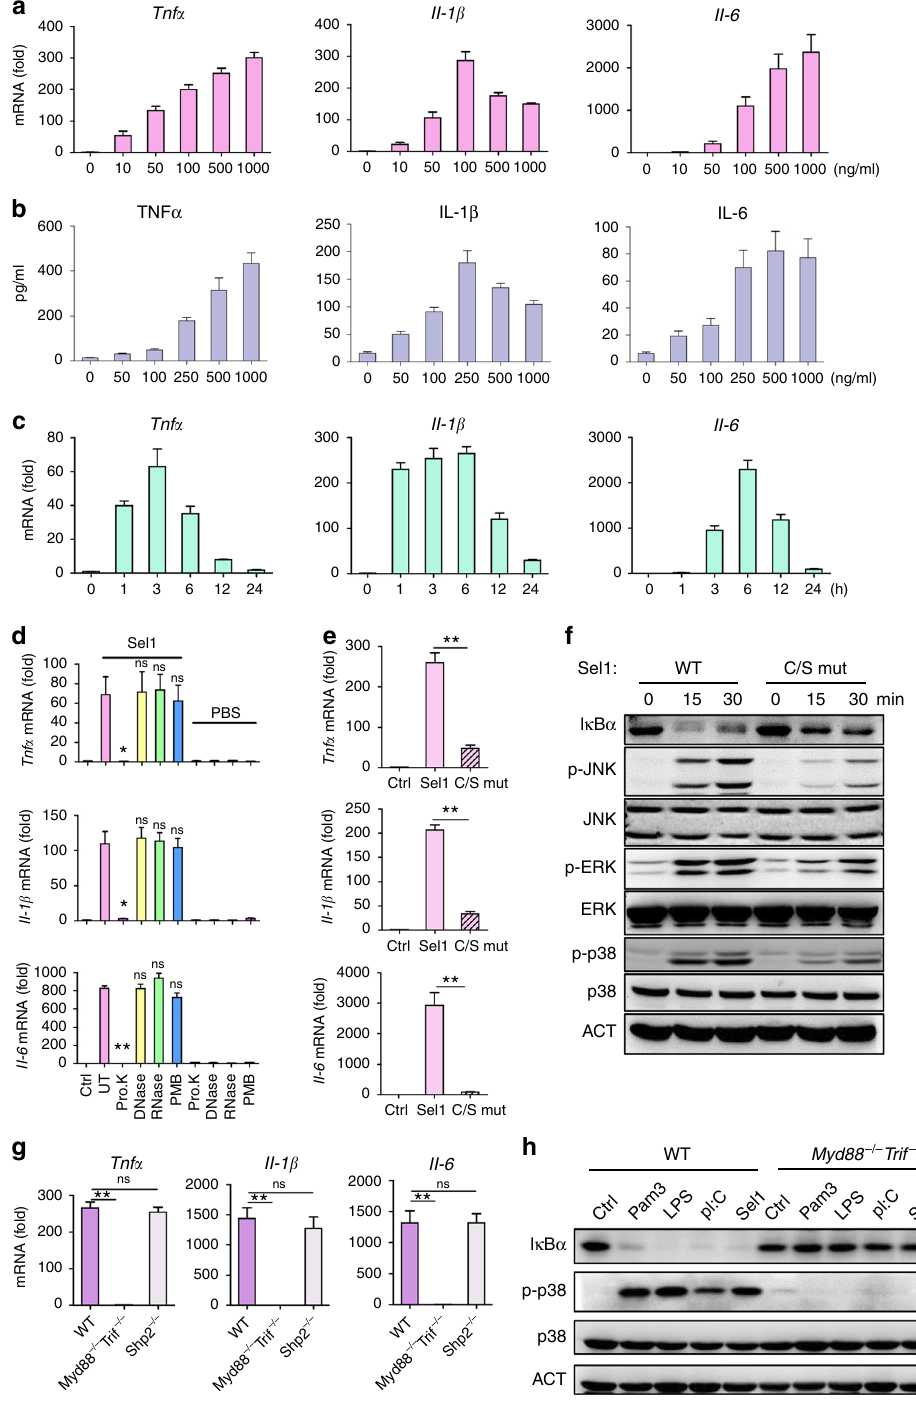
Fig. 3 Sel1 activates MyD88/Trif-dependent in fl ammatory responses. a , b Bone marrow-derived macrophages (BMDMs) were stimulated with different doses of Sel1 for 3 h ( a ) or 24 h ( b ), and the cytokine production was assessed by real-time quantitative PCR (qRT-PCR) ( a ) or by enzyme-linked immunosorbent assay (ELISA) ( b ), respectively. c BMDMs were stimulated with 300 ng/ml of Sel1 for various times and the cytokine production was assessed by qRT-PCR. d The Sel1 proteins were either untreated (UT) or treated with proteinase K, DNase, RNase or PMB, prior to stimulation. BMDMs were stimulated with pretreated Sel1 for 3 h, and the cytokines were assessed by qRT-PCR. e , f Puri fi ed wild-type (WT) or Cys to Ser mutant (C/S mut) Sel1 proteins were used for BMDM stimulation. The cytokine production ( e ) and signaling pathways ( f ) were analyzed by qRT-PCR or western blotting, respectively. g The WT, Myd88 − / − Trif − / − , or Shp2 − / − BMDMs were stimulated with Sel1, and cytokine production was quanti fi ed by qRT-PCR. h WT, Myd88 − / − Trif − / − BMDMs were stimulated with the indicated stimuli for 30 min, and signaling pathways were analyzed by western blotting. Pam3C Pam3CSK4, LPS lipopolysaccharide, pI:C polyinosinic:polycytidylic acid. Data represent the average expression levels of each gene from three ( a – e , g ) independent experiments. Bars, mean ± SEM. Data are representative of at least three ( f , h ) independent experiments with similar results; * p < 0.05, ** p < 0.01, ns: no signi fi cance, by Student ’ s t -test NATURE COMMUNICATIONS| (2019) 10:1015